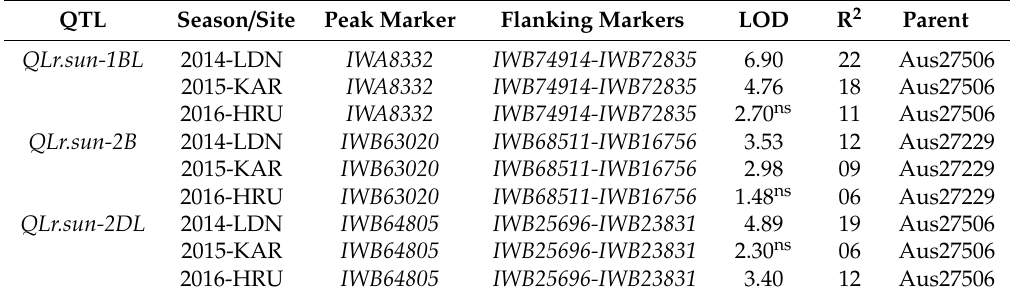
Table 1. Leaf rust quantitative trait loci (QTL) detected in the Aus27506 / Aus27229 RIL population. QTL Season / Site Peak Marker